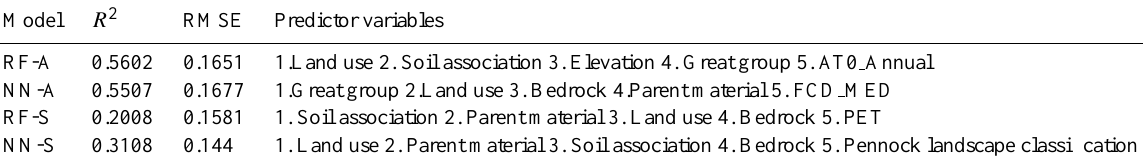
Table 2. Modelling results (using the validation dataset) for random forest and artificial neural network models. The suffix “A” indicates the results are for the A horizon and the suffix “S” indicates the results are for the subsoil. The top five predictor variables are ranked in order of